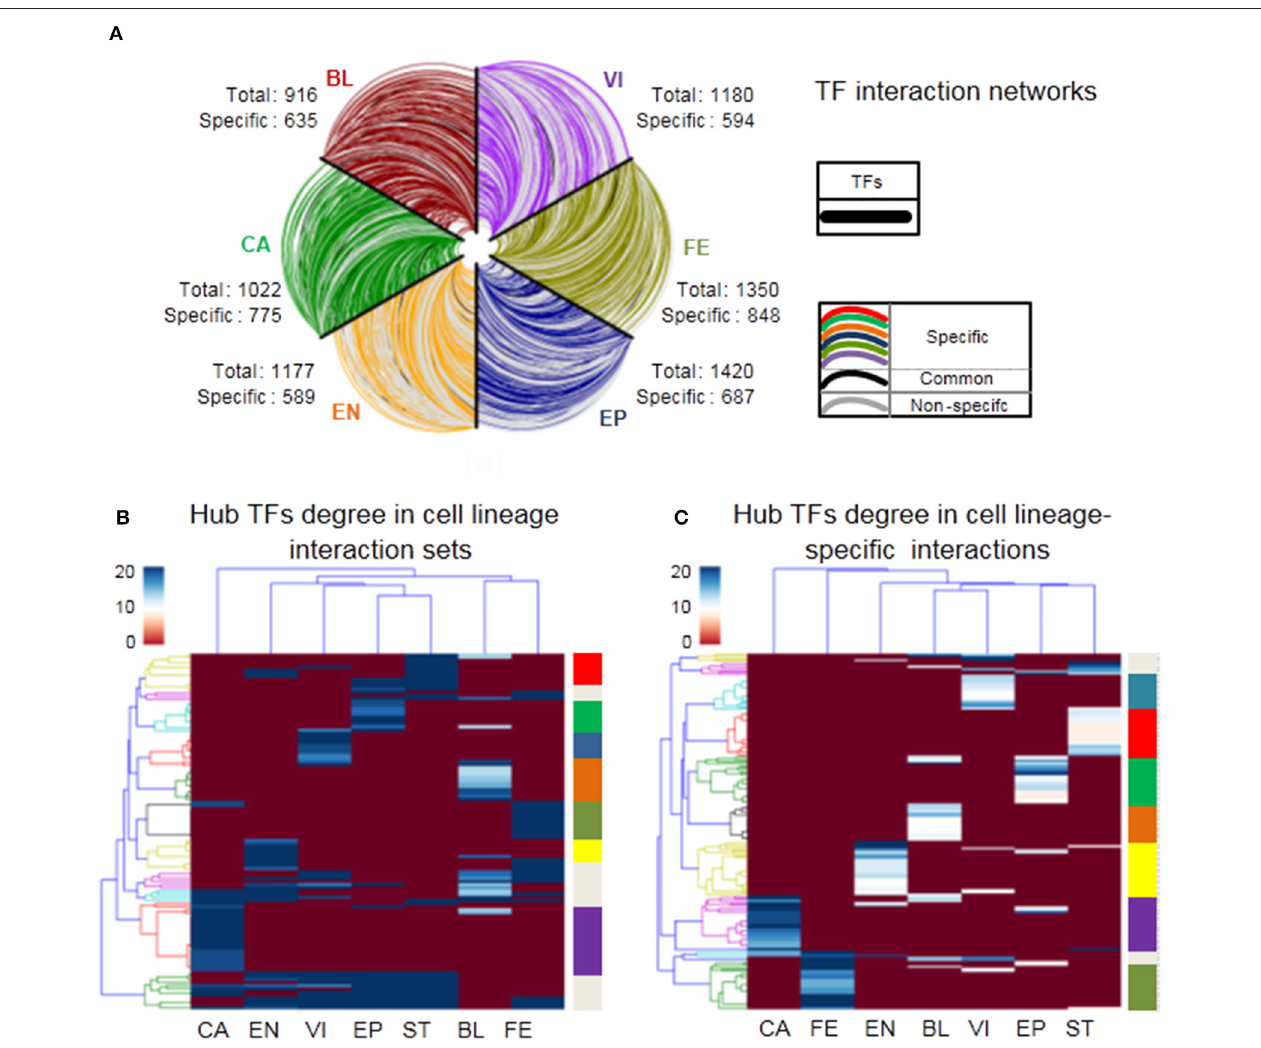
FIGURE 5 | Characteristics of cell lineage networks. (A) TF interactions among all TFs of six cell lineages. All TFs are similarly ordered in each axis, cell lineage-specific edges are labeled by different colors in the legend, edges occurred in two or more cell lineages are colored gray, and edges occurred in all cell lineages are colored black. (B,C) Heatmap showing hierarchical clustering of hub TFs degree (top 5%) in cell lineage interactionsand cell lineage-specific interactions respectively, where branch colors of the y-axis represent which classes there TF nodes belong to.